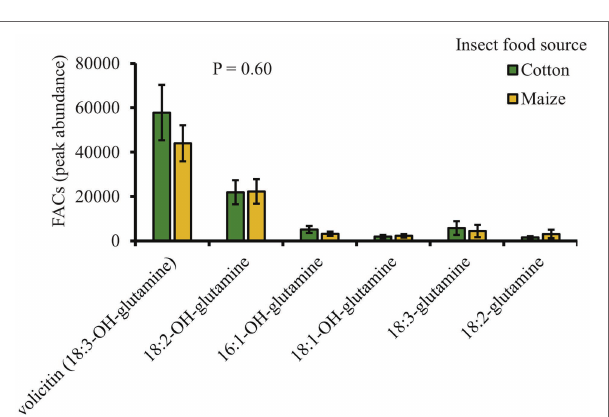
FIGURE 6 | Volicitin and volicitin-like compounds are present in the regurgitant of S. exigua caterpillars fed on cotton and maize leaves ( n = 5). Bars represent average (±SE). p values are given for treatment comparisons [GLM (family, Gaussian)], followed by pairwise comparisons of